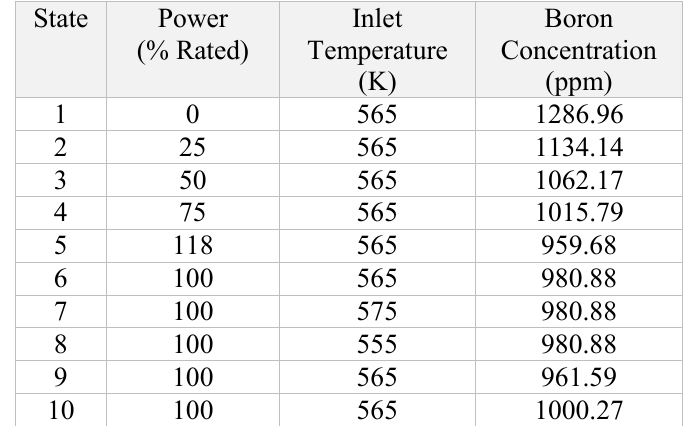
Table I. State point values used in generating nodal parameters and assessing NESTLE